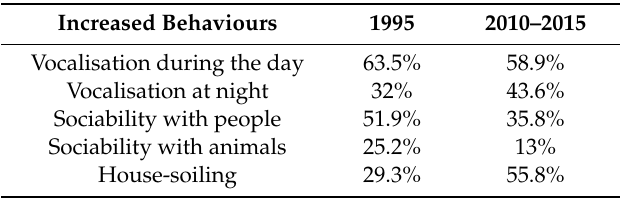
Table 1. Increased behavioural changes 1 . Percentages from both surveys where behavioural changes were reported to be increased by the owners of the elderly cats.